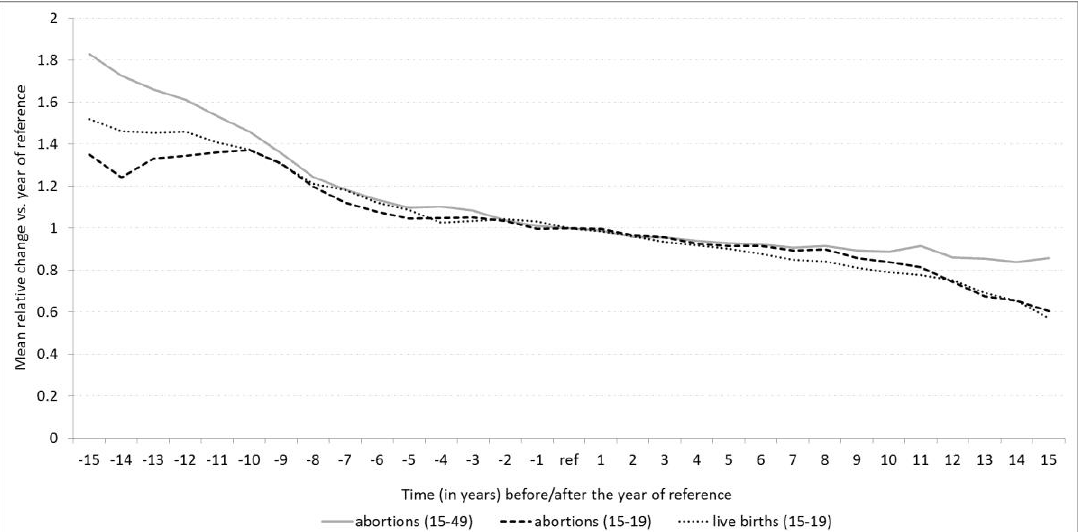
Figure 1. Long-term analysis of abortion/live birth rates for n=26 European countries 15 years before and after the year of